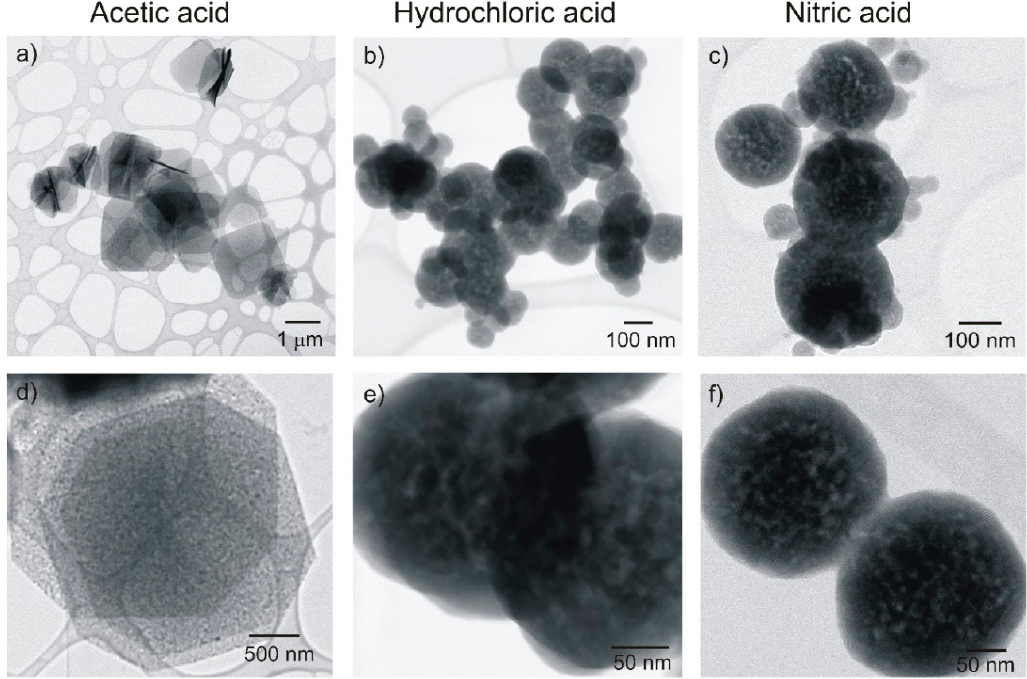
Figure 7. Scanning transmission electron microscopy (STEM) images of Y 2 O 3 :Yb:Eu nanostructures produced by hydrothermal method assisted by microwave irradiation, and using ( a ) and ( d ) acetic acid, ( b ) and ( e ) hydrochloric acid, and ( c ) and ( f ) nitric acid after calcination at 700 °C. The nanosheets had an average size of ~2.5 µ m and thickness of ~50 nm, while the size of the spheres varied with the acid used. For the hydrochloric acid, the structures had 192 ± 25 nm, and